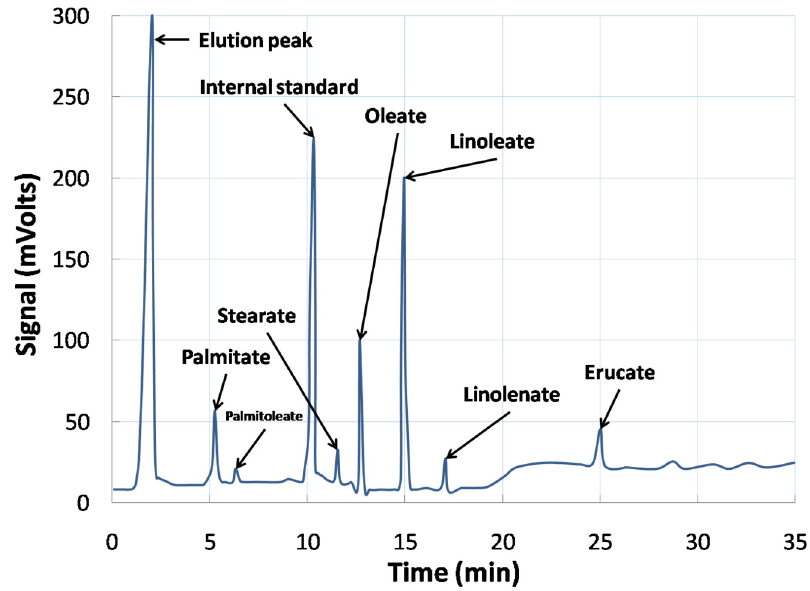
Figure 4. Chromatogram with the main fatty acid methyl esters found in cardoon biodiesel.